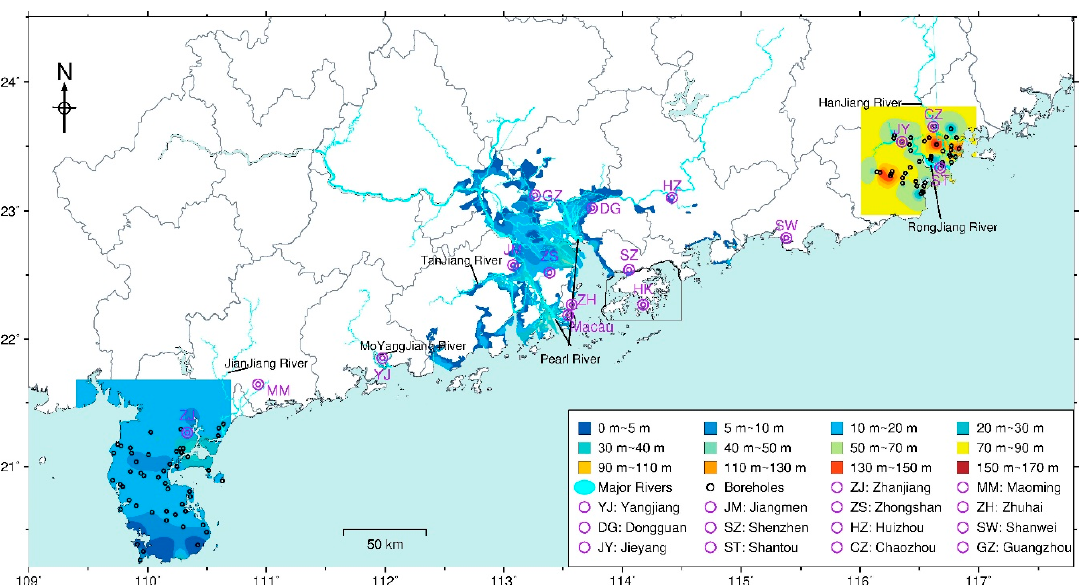
Figure 2. Sedimentary thickness map of the Leizhou Peninsula (LZP), Pearl River Delta (PRD) and Chanshao Plain (CSP). The cyan filled lines represent the primary rivers along the coastline. The black hollow circles represent the locations of the sediment depth measurements collected from boreholes. The purple circles represent the city along the coastal areas of Guangdong